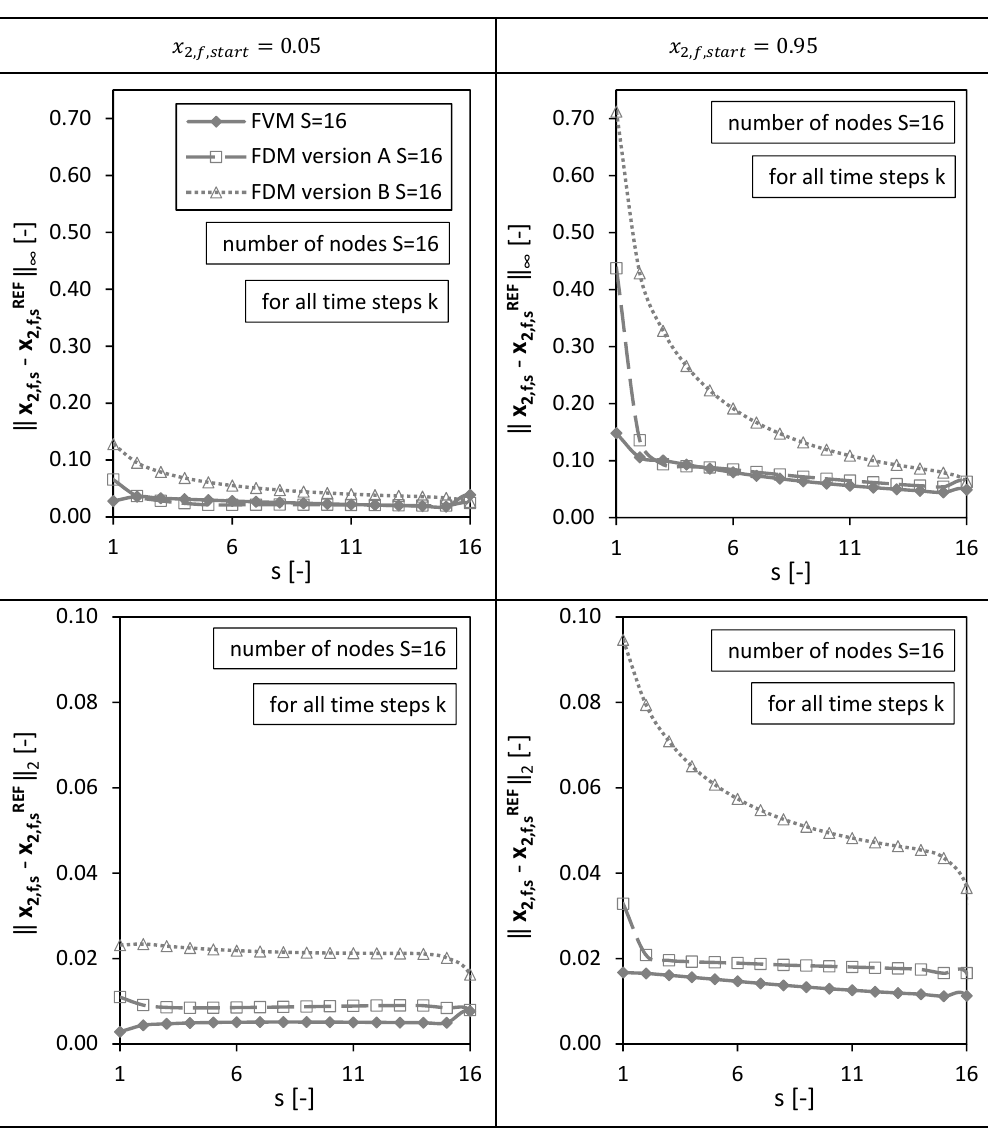
Figure 5. Spatial l ∞ and l 2 error distribution calculated for all drying time steps k for the FVM, FDM version A and B using x (cid:2870),(cid:2916)(cid:2929)(cid:2930)(cid:2911)(cid:2928)(cid:2930) = 0.05 (left panels) and x (cid:2870),(cid:2916)(cid:2929)(cid:2930)(cid:2911)(cid:2928)(cid:2930) = 0.95 (right panels). Calculation settings: N = 26, S = 16, S REF = 64, Δ t = 0.05 s (for FVM, FDM version A and B). In a third step, the overall errors calculated for all spatial nodes of the packed bed height ( 𝑠 = 1,…,𝑆 ) and for all drying time steps ( 𝑘 = 1,…,𝐾 ) are presented in Figure 6 for different discretizations/grids ( 𝑆 = 2;4;8;16; 32 ) and both investigated initial conditions. It is obvious that the overall errors are higher for the initial condition 𝑥 (cid:2870),(cid:3033),(cid:3046)(cid:3047)(cid:3028)(cid:3045)(cid:3047) = 0.95 compared to the calculations using 𝑥 (cid:2870),(cid:3033),(cid:3046)(cid:3047)(cid:3028)(cid:3045)(cid:3047) = 0.05 . For both initial conditions and both errors, 𝑙 (cid:2998) and 𝑙 (cid:2870) , the FVM shows the best convergence behavior, meaning the error decreases the fastest for an increasing total number of grid points 𝑆 (or smaller grid sizes ∆𝑥 ).